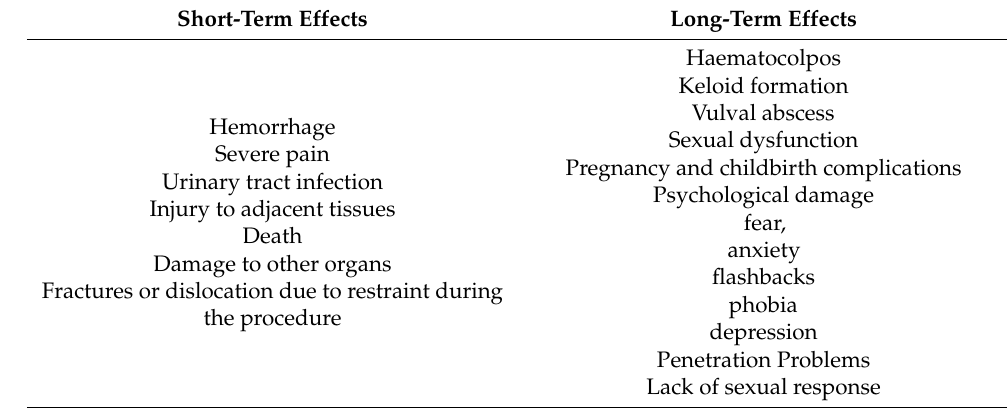
Table 2. Effects of Female Genital